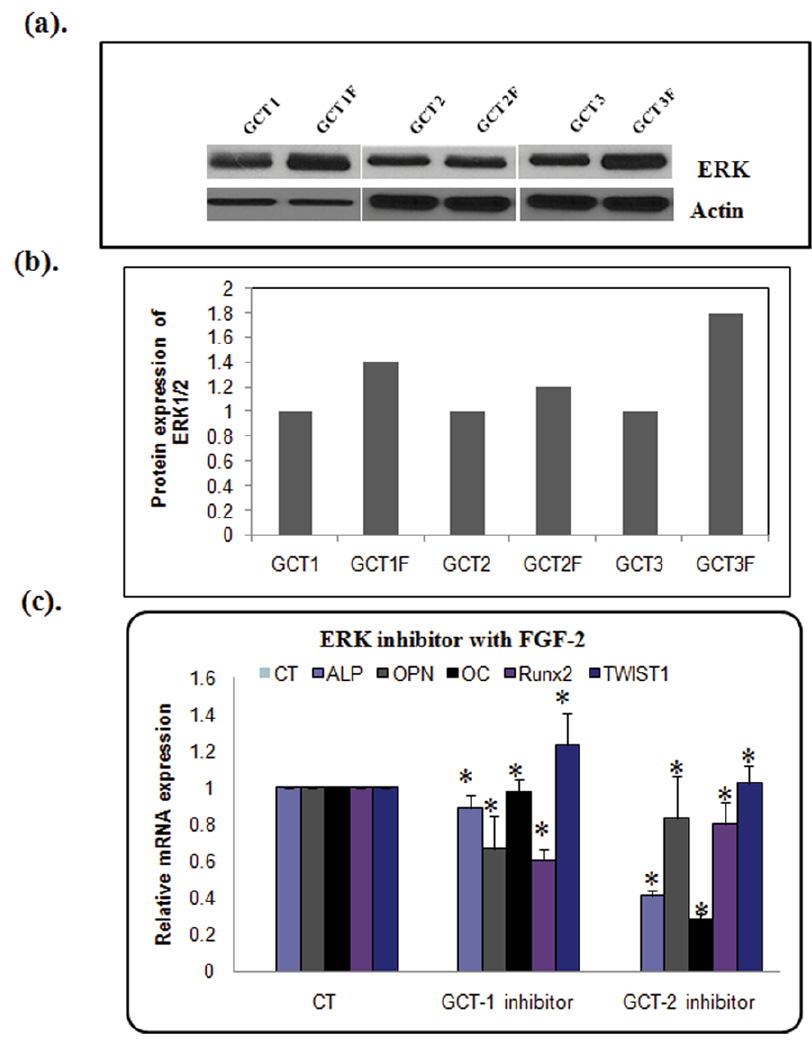
Figure 7. FGF2 signaling through ERK in osteoblast differentiation in GCT stromal cells. ( a ) Western blot analysis ( b ) and quantification showed that FGF-2 stimulation resulted in increased phosphorylation of ERK1/2 (p-ERK1/2), compared to untreated GCT cells. b -Actin was used as loading control. ( c ). Inhibition of osteoblastic gene expression by ERK inhibitor in GCT stromal cells based on real-time RT-PCR. GCT stromal cells were treated with 1 nM ERK-inhibitor PD98059 (all diluted in DMSO) for 24 h in serum-free medium. mRNAs were purified, cDNAs were synthesized, and the samples were analyzed by real-time PCR. The DD CT method was used to calculate the real-time RT-PCR fold change using RPS18 mRNA as an endogenous control, and all changes in expression are relative to the control without treatment. Three independent real-time PCR runs were performed on each sample.